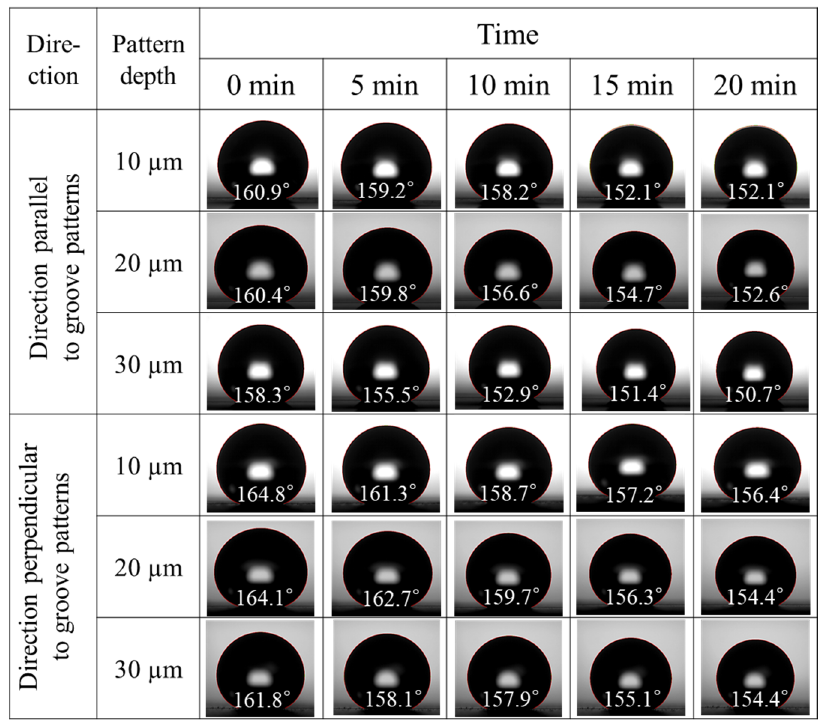
Figure 13. The change of apparent contact angle on the groove pattern surfaces with coating according to a time of 20 min.